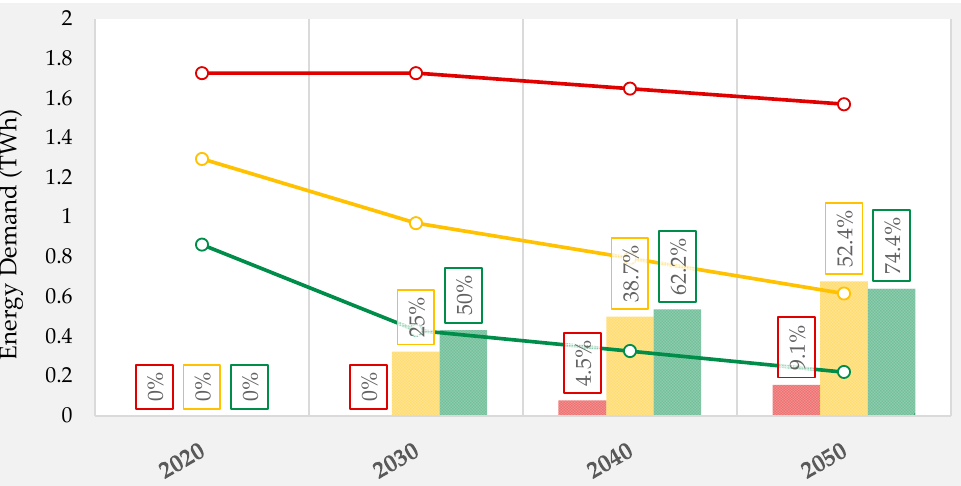
Figure 5. Calculation of energy demand (lines) and reduction compared to 2020 (bars) for biologics manufacturing in Germany. Three process improvement scenarios are considered: red = worst case (low impact and slow industrialization); orange = realistic (impact as discussed, normal industrialization time) and green = best case (highest impact and fast industrialization). Table 3. Calculated data using reference values as shown in minimum, average and maximum greenhouse gas (GHG) emissions and cumulative energy demand (CED) of biologicals manufacturing in Germany for the year 2020.